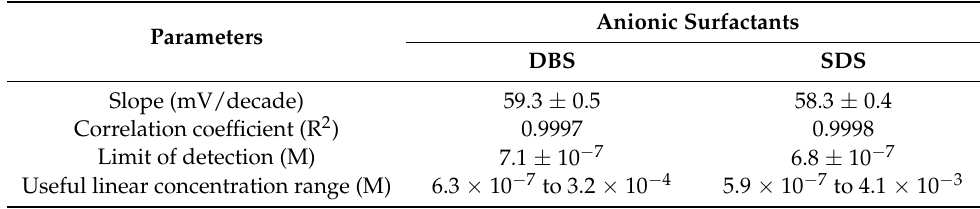
Table 2. Response characteristics of DODI–TPB surfactant sensor to anionic surfactants DBS and SDS in H 2 O, given together with ± 95% confidence